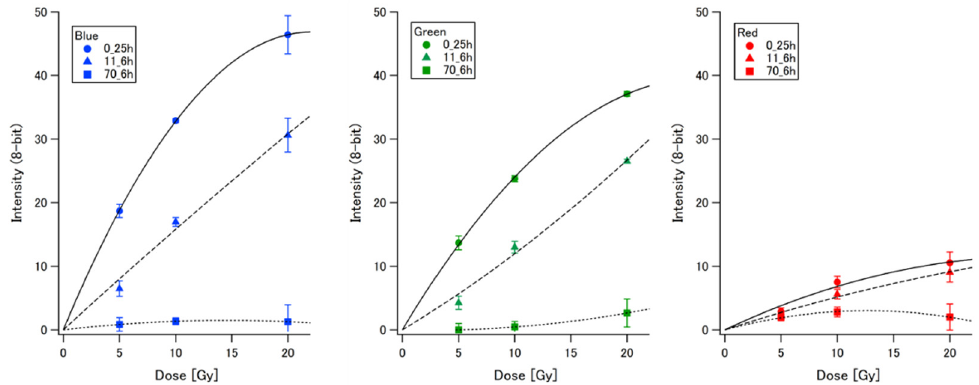
Figure 4. Dose responses of the inverted 8-bit intensities of blue ( left ), green ( middle ) and red ( right ) components of the PAISiN images acquired at room temperature (20 °C) at 0.25 h, 11.6 h and 70.6 h after γ -ray